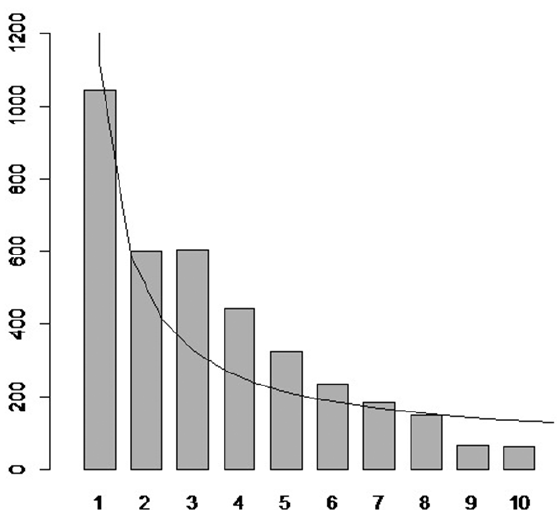
Figu 2. Species richness distribution for 3715 species in Xinjiang across the 10 spatial range classes. Spatial range was measured based on the number of geographical regions, without specific reference to particular regions. The line represents the least-squares regression using a hyperbola model with 61.07 and 1060.20 as the a and b parameters, respectively ( R 2 =0.89, P